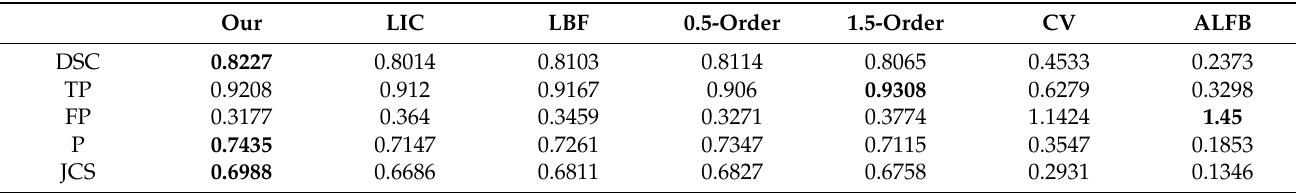
Table 2. The corresponding evaluation index values of Figure 5.